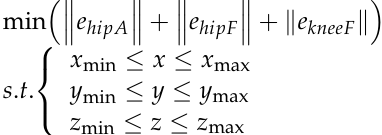
Figure 7. Cuff end location estimation along axes. and knee flexion,